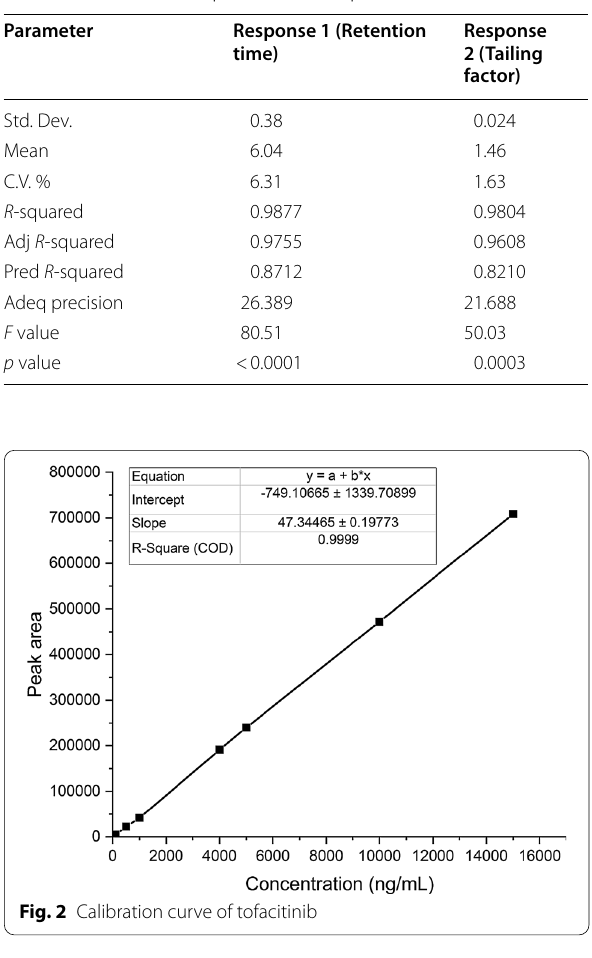
Table 2 ANOVA for response surface quadratic model